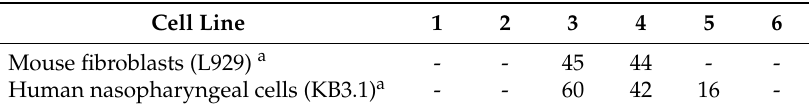
Table 2. Cytotoxicity ( µ M) of compounds 1 – 6 .